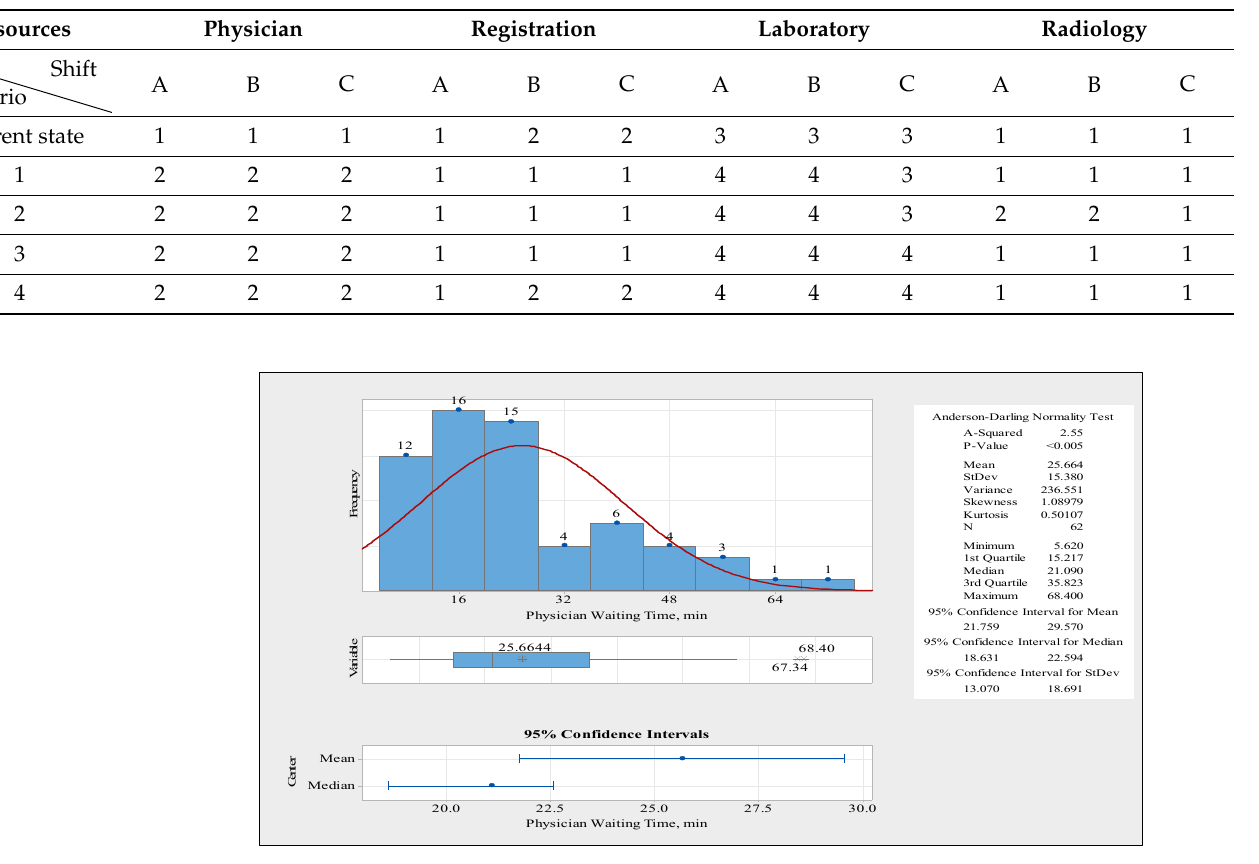
Table 8. The configuration of resources in the proposed scenarios.